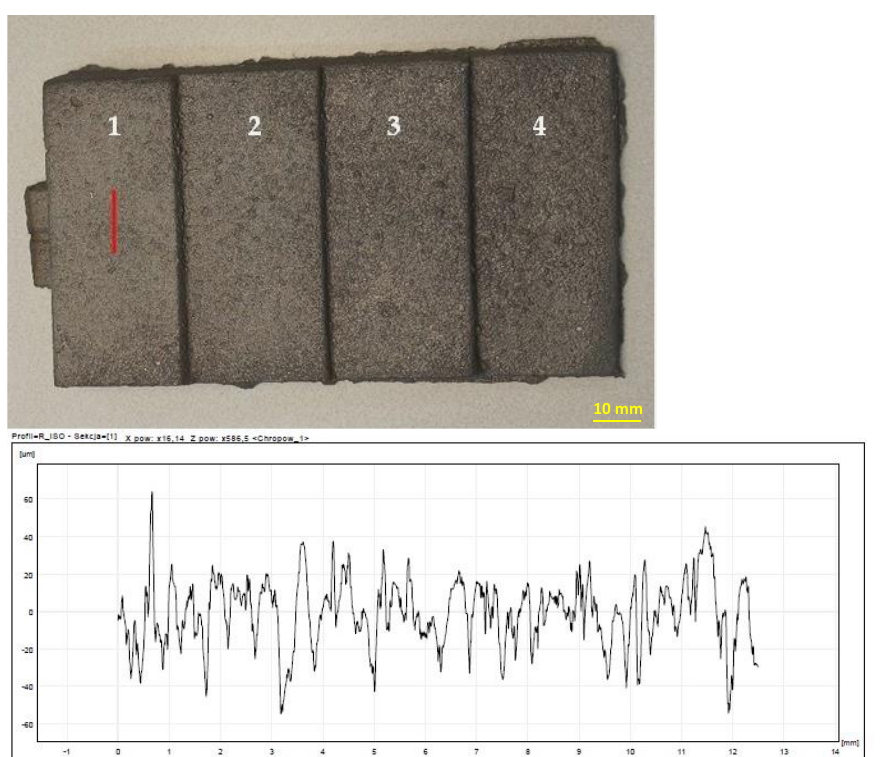
Figure 15. Raw casting made in a mold with a mass of MB 2%. A chart of an example of surface roughness for the 1st “stair” of the casting. 1–4 are numbers of stairs of the casting.